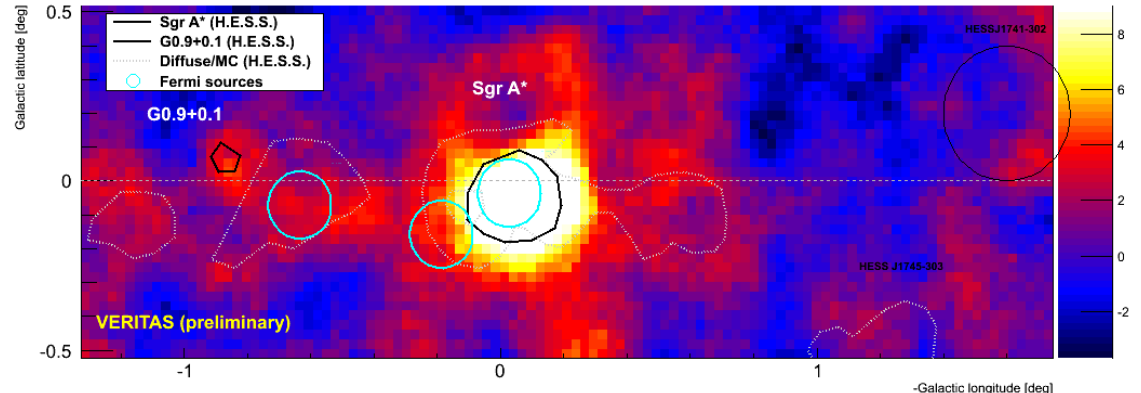
Figure 3: VERITAS sky map of the GC region (smoothed excess significances, ring background, scale truncated). The black contour lines indicate the GC and the supernova remnant G 0.9+0.1 as seen by H.E.S.S. [8]. The gray dashed lines indicate the H.E.S.S. diffuse emission along the galactic plane and from HESS J1745-303 [9]. The position of HESS J1741-302 is indicated, as well (circle); the flux/spectrum of this source make it very unlikely to be detected in VERITAS LZA observations. The solid circles (cyan color) indicate the positions of the MeV/GeV sources taken from the second Fermi /LAT catalog